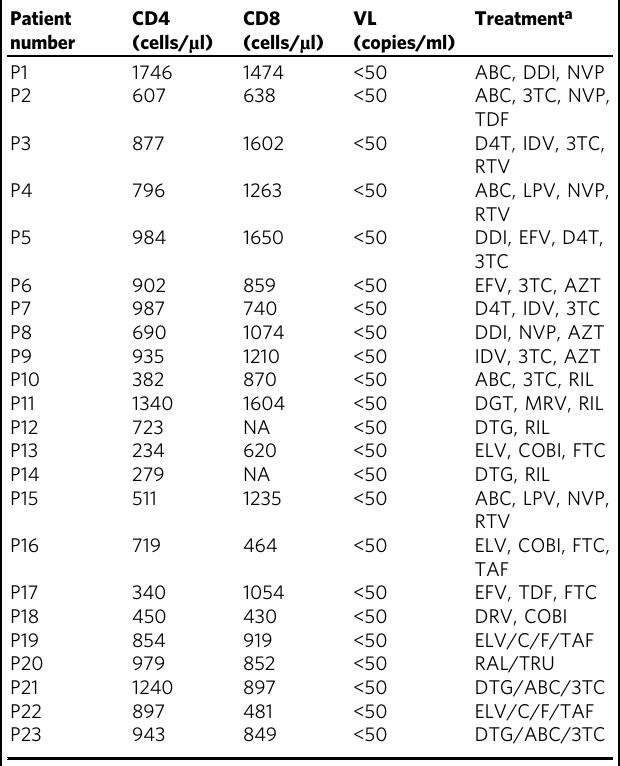
Table 1 Immunological and virological characteristics of HIV + individuals Patient